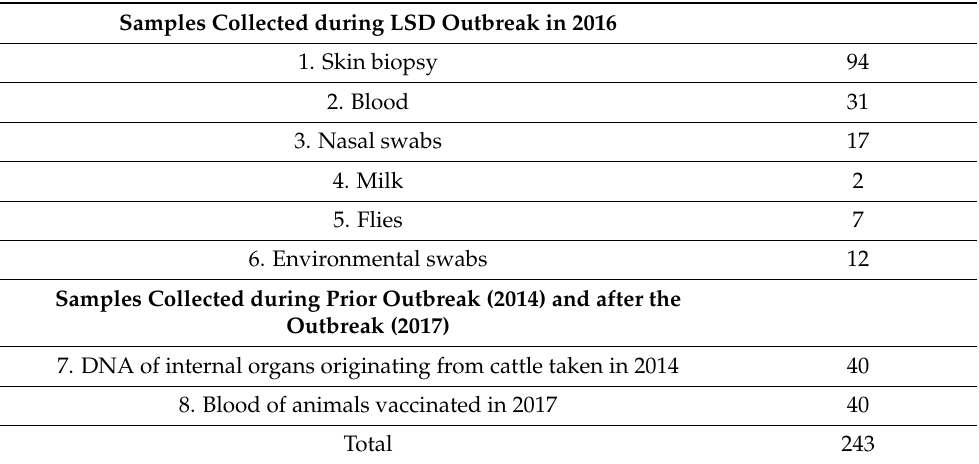
Table 3. Number and type of clinical samples used in assay